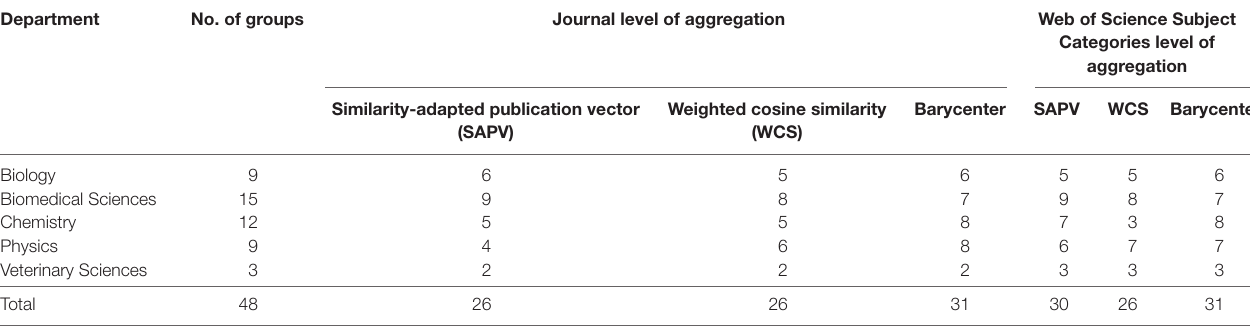
Table 7 | The distribution of total scores for six approaches according to procedure